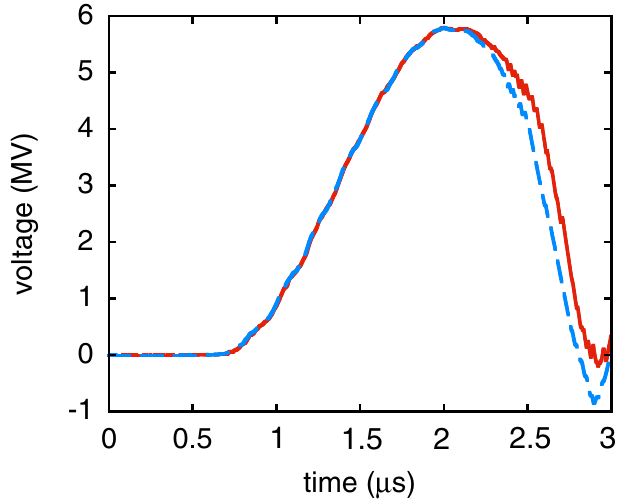
FIG. 2. (Color) Time histories of the voltage applied to the two ZR intermediate-storage capacitors that were used for the 5.8- MV